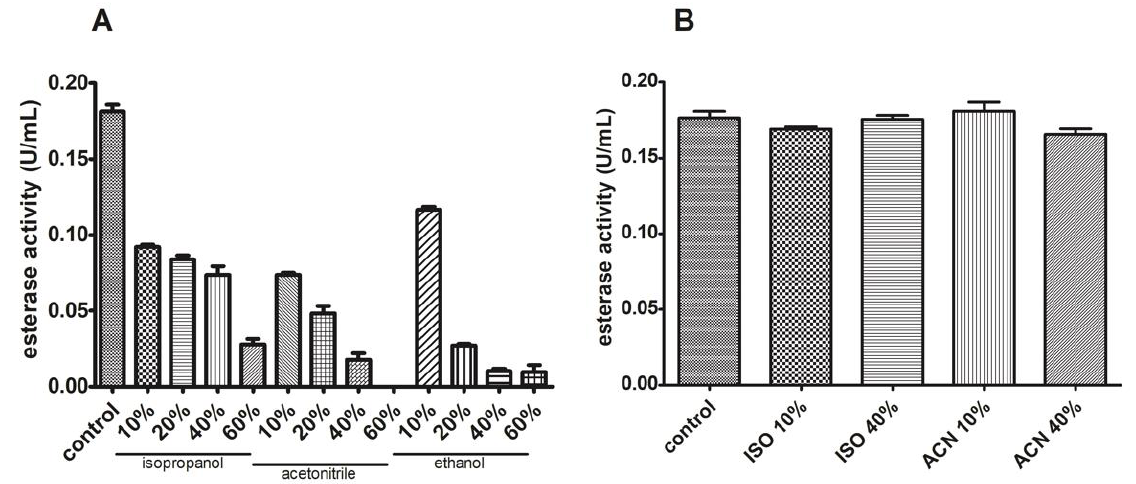
Figure 12. Esterase activity is reversibly lowered in the presence of organic solvents. Esterase activity decreased when isopropanol, acetonitrile, and ethanol were added ( A ) but sample reconstitution in an aqueous reaction mixture reverses this ( B ).